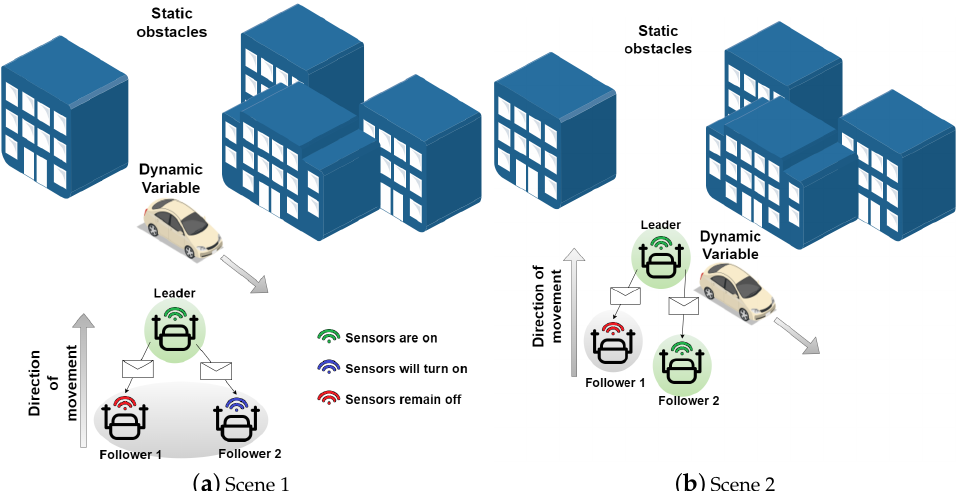
Figure 1. Swarm in a static environment with only one dynamic obstacle. ( a ) the initial scene where the leader (encircled by light green) has its ranging sensors turned on, performs all the processing, and transferring the information about the surroundings to its followers, ( b ) the Follower 2, upon performing necessary calculations, realizes that the dynamic obstacle is potentially moving in its path and turns on its sensors to be able to perform collision avoidance actively. In both scenes, Follower 1 does not turn its sensors on, since the dynamic obstacle is moving in the other direction and does not pose a potential collision threat. For bypassing the static obstacles, Follower 1 translates the received coordinates to generate escape